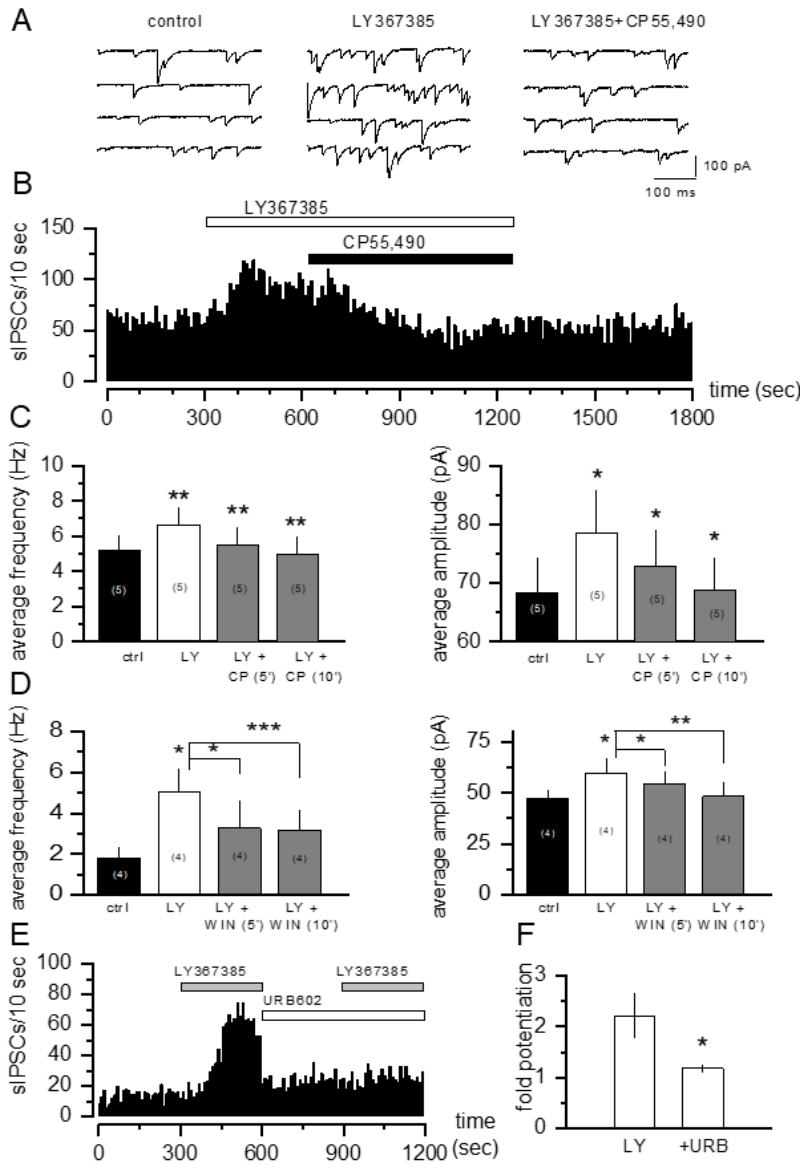
Figure 2. The CB1 receptor agonist CP55,490 and the monoacylglycerol lipase inhibitor URB602 revert the increase in sIPSC frequency and amplitude induced by the mGlu1 receptor antagonist LY367385. ( A ) sIPSCs recorded from CA1 pyramidal single cells under control condition ( left ), during bath application of 300 µ M LY367385 ( middle ) and during bath application of LY367385 plus 10 µ CP55,490 ( right ). ( B ) Frequency time course recorded from a single cell showing that 10 µ M CP55,490 reverts the increase in sIPSC frequency induced by LY367385. ( C , D ) Bar graphs showing that 10 µ M CP55,490 and WIN 55,212-2 revert the increase in sIPSC frequency ( left panel ) and amplitude ( right panel ) induced by LY367385, 5 and 10 min after application. ( E ) Frequency time course recorded from a single cell showing that 100 µ M URB602 reverts the increase in sIPSC frequency induced by LY367685. URB602 was preincubated for 5 min and no changes of sIPSC frequency were noticed. ( F ) Bar graphs showing the reduction of the effects of LY367385 on sIPSC frequency following URB602 pre-incubation. The number of cells tested is in parenthesis; values are the means ± SEM, n = 4. * p < 0.05, ** p <0.01 and *** p <0.001 vs. LY367385 potentiation, Student’s t test.